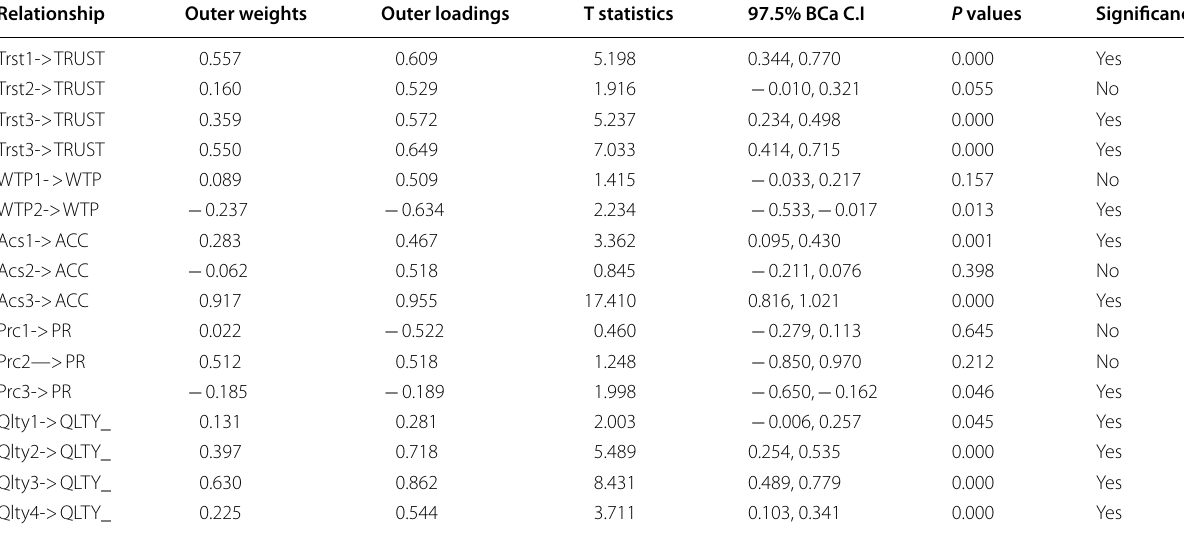
Table 3 Formative constructs outer weights significance testing result Relationship